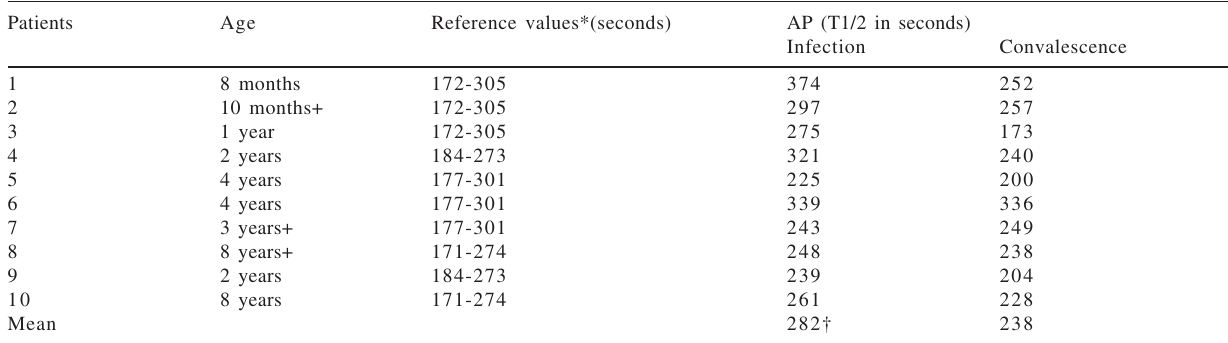
Table 2 - Alternative pathway (AP) hemolytic activity, expressed as T1/2 (in seconds), during and after menigococcal meningitis.